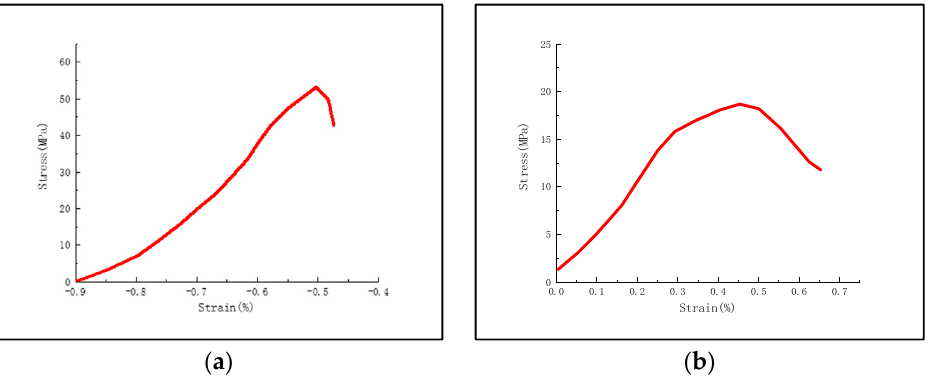
Figure 9. Uniaxial compressive strength test before and after salt solution. ( a ) Uniaxial compressive strength before salt solution; ( b ) Uniaxial compressive strength after salt solution.